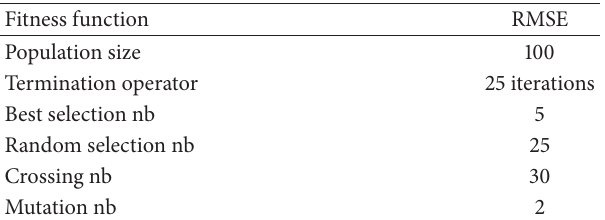
Table 2: GA parameters for Kubelka-Munk inversion